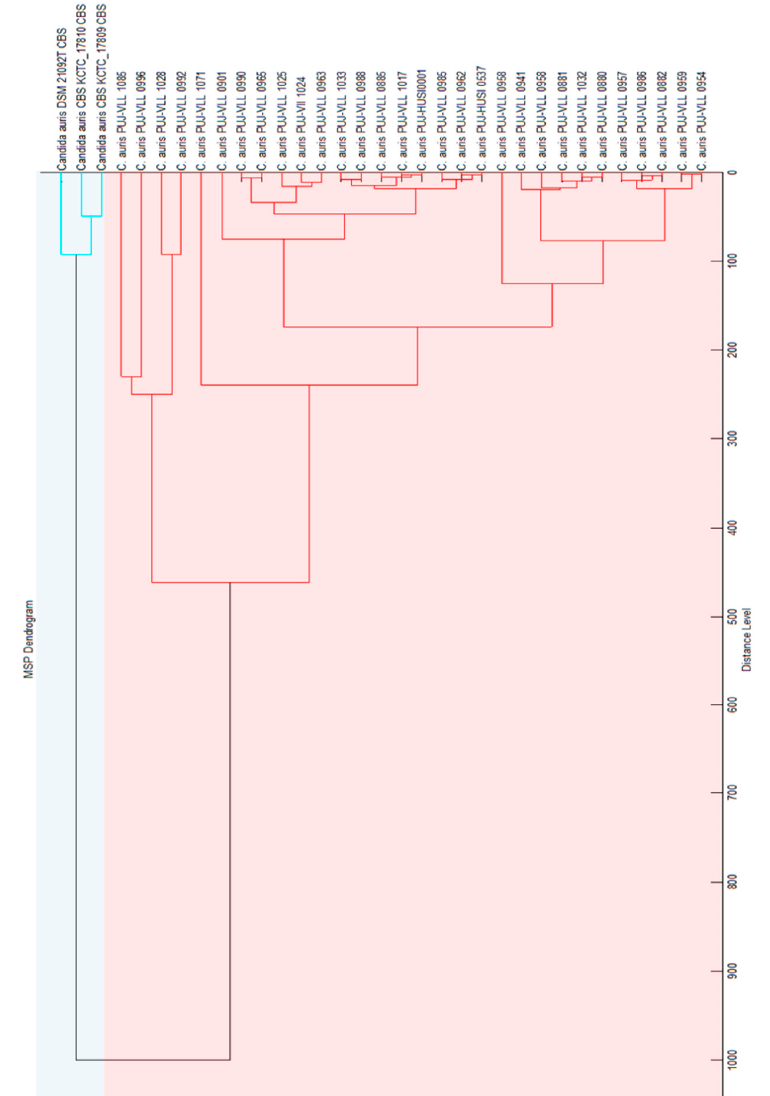
Figure 2. C. auris BDAL library (three strains) and C. auris Colombia library (30 strains) dendrogram.